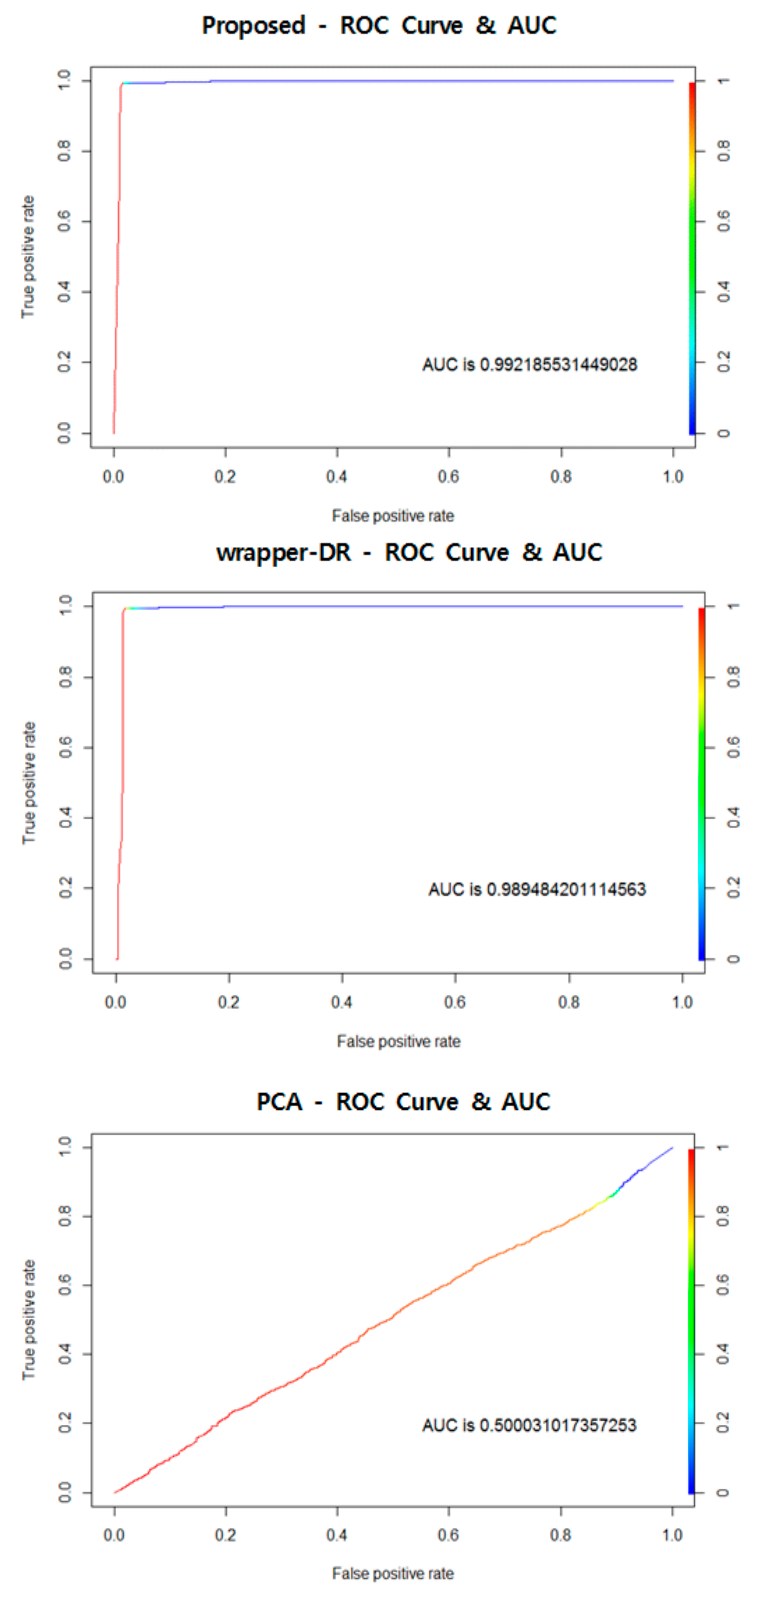
Figure 9. Result of ROC curve and AUC.